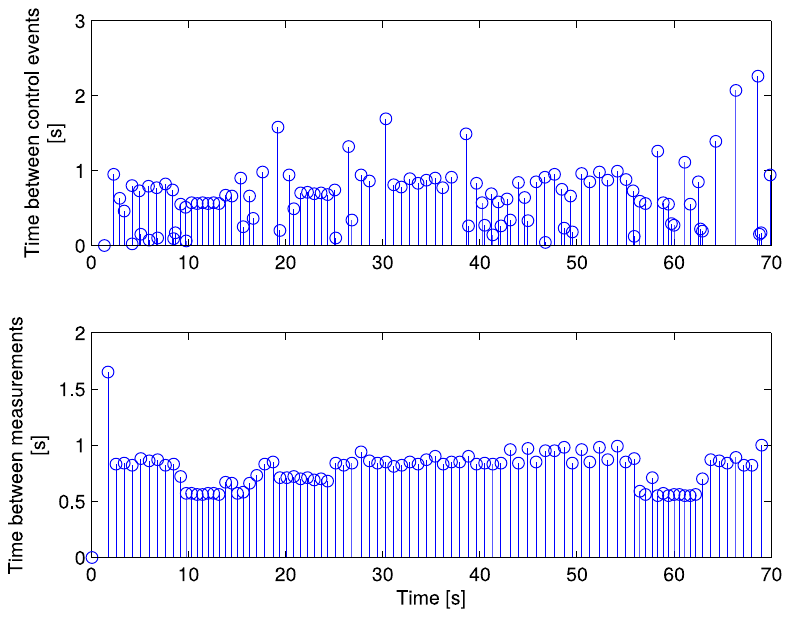
Figure 9. Time between controller and sensor